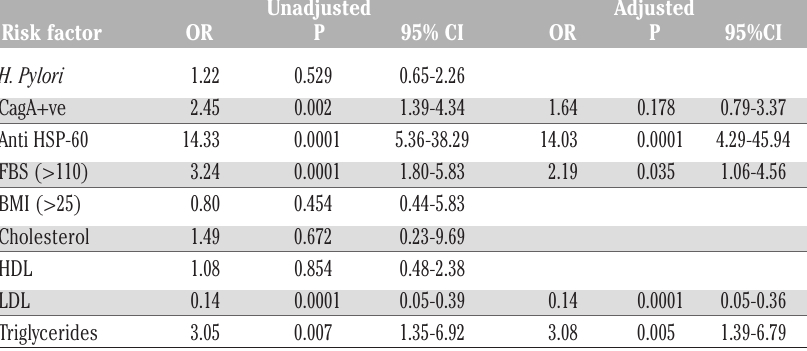
Table 2. Multivariate analysis of risk factors.